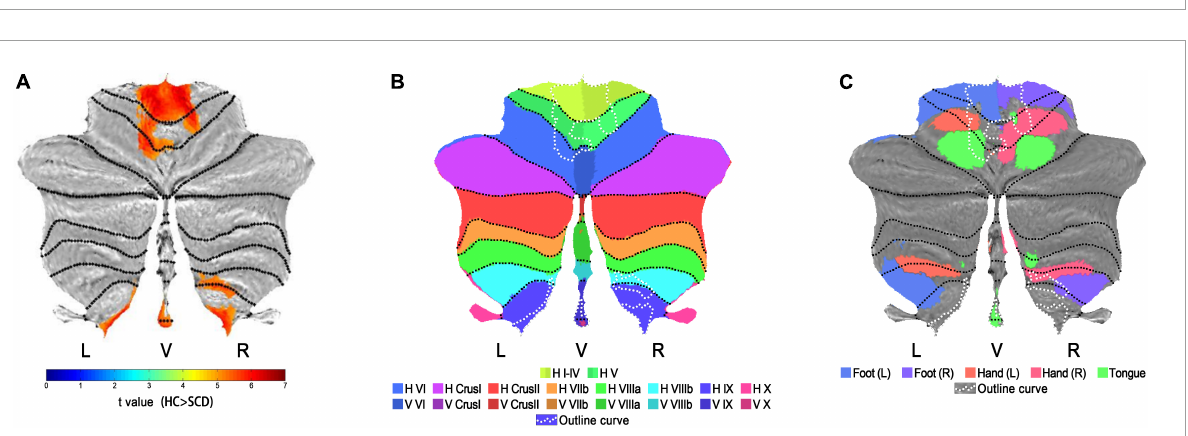
FIGURE2 Visualization on flatmaps for cerebellar-located Cluster 1. (A) The t-map of Normalized CBF group results (HC > SCD) projected to the cerebellar SUIT flatmap. Regions displayed in warm colors represent the significant CBF decrease in SCD patients. (B) Outline curves of results in flatmap (A) shown in white dotted lines are overlaid onto the flatmap of anatomical distributions for cerebellar lobules I-X. Note that for lobule VI-X, two hemispheric and one vermal compartment (displayed in slightly different colors) are defined. (C) Outline curves of results in flatmap (A) shown in white dotted lines are overlaid onto the flatmap of the sensorimotor topography for activation related to hand, foot and tongue movement activations. HC, healthy control; SCD, spinocerebellar degeneration; L, left; R, right; V, vermis; H, hemisphere; Roman numerals I-X, number of cerebellar lobules (Schmahmann et al.,